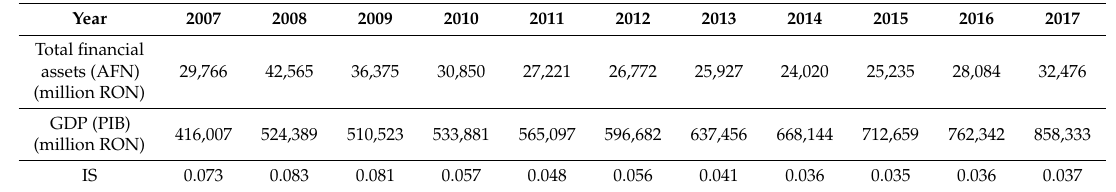
Table 6. NFI expansion indicator (IS) values for the period 2007–2017.